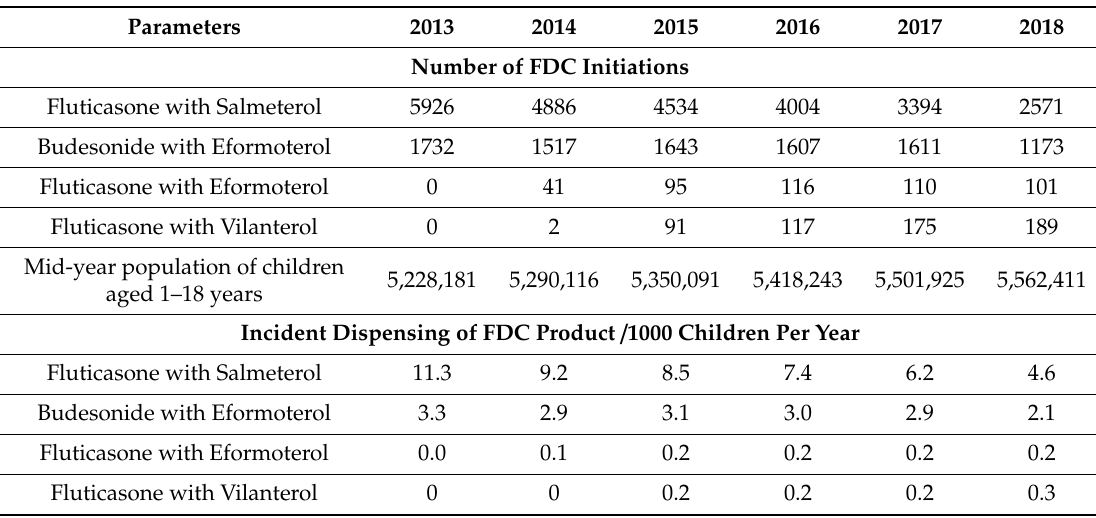
Table 1. Annual fixed dose combination product specific incidence / 1000 children per year dispensed in 10% PBS sample of Australian children aged 1–18 years,